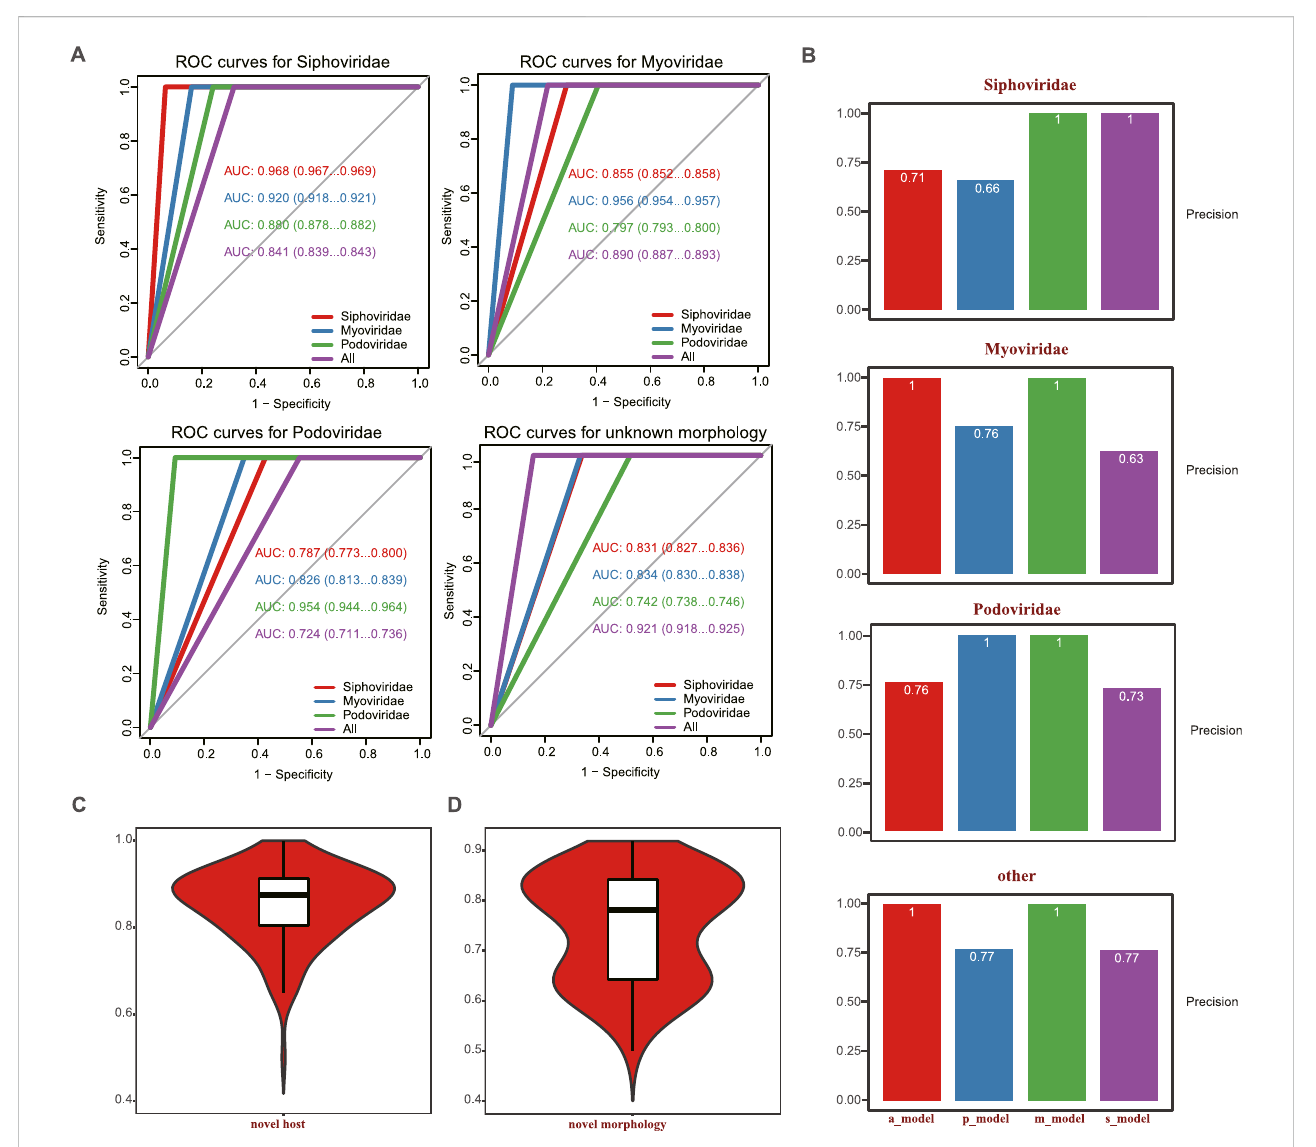
FIGURE 3 Comparison ofthepredictivepowerofthePhageTailFinder for992completephages usingfourmodels. (A) ROC curveshowingthepredictivepower of four models in the 992 complete phages, with the AUC values of 0.968, 0.956, 0.954, and 0.921. (B) . Precision values per morphology using corresponding models. (C) ROCcurveshowingthepredictivepowerofanovelphagebasedontaxonomy. (D) ROCcurveshowingthepredictivepowerofnovelphagebased on